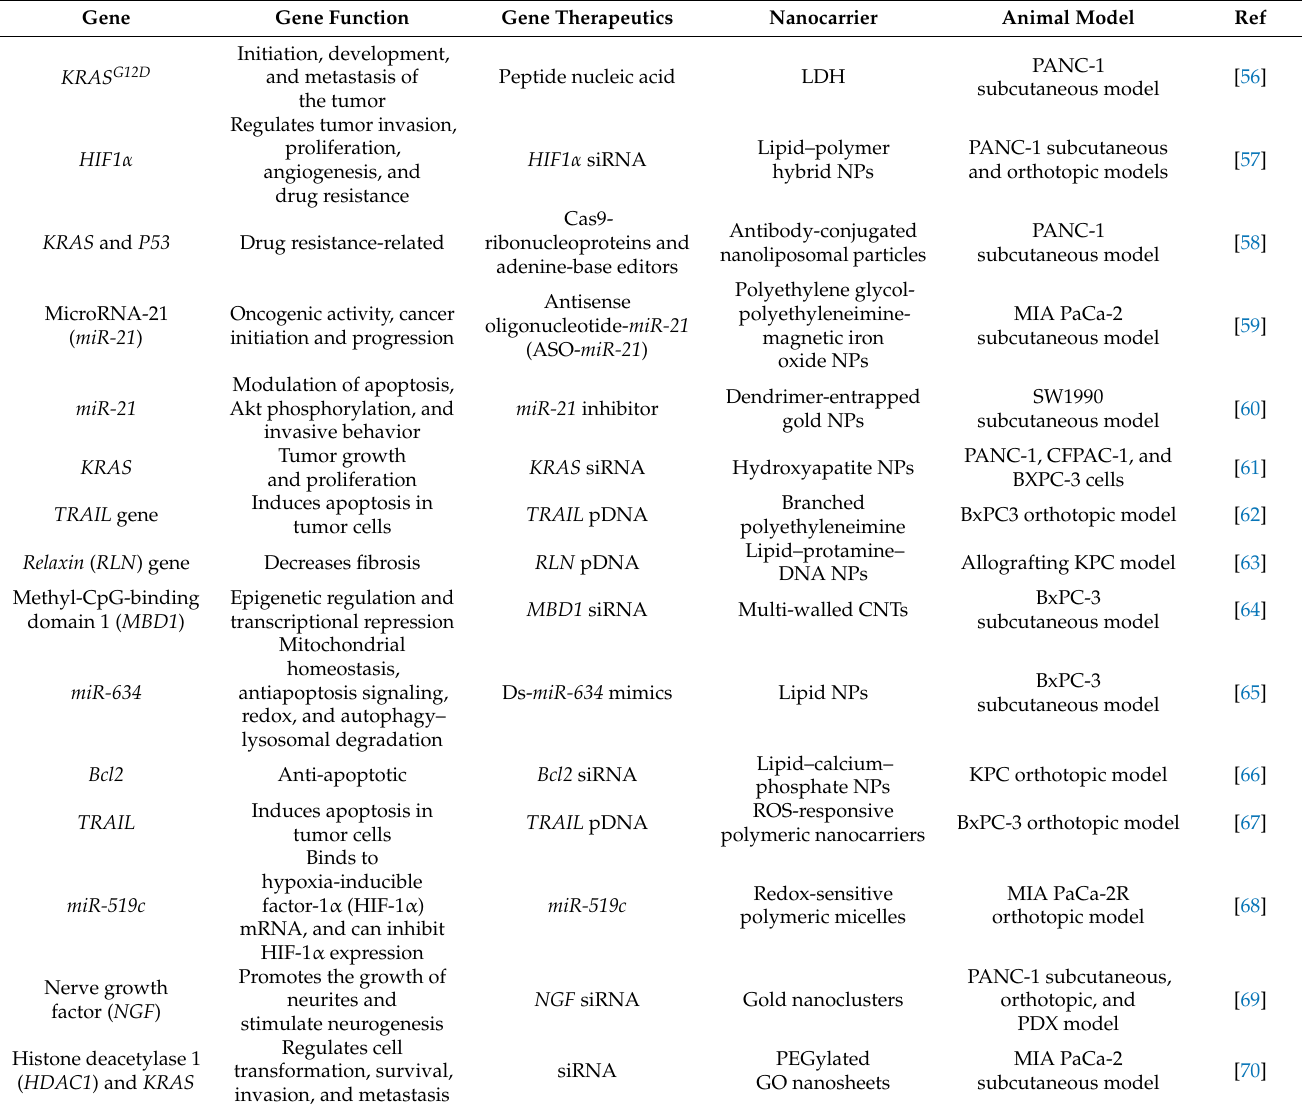
Table 3. Recent advances in nanosystem-mediated gene therapy for